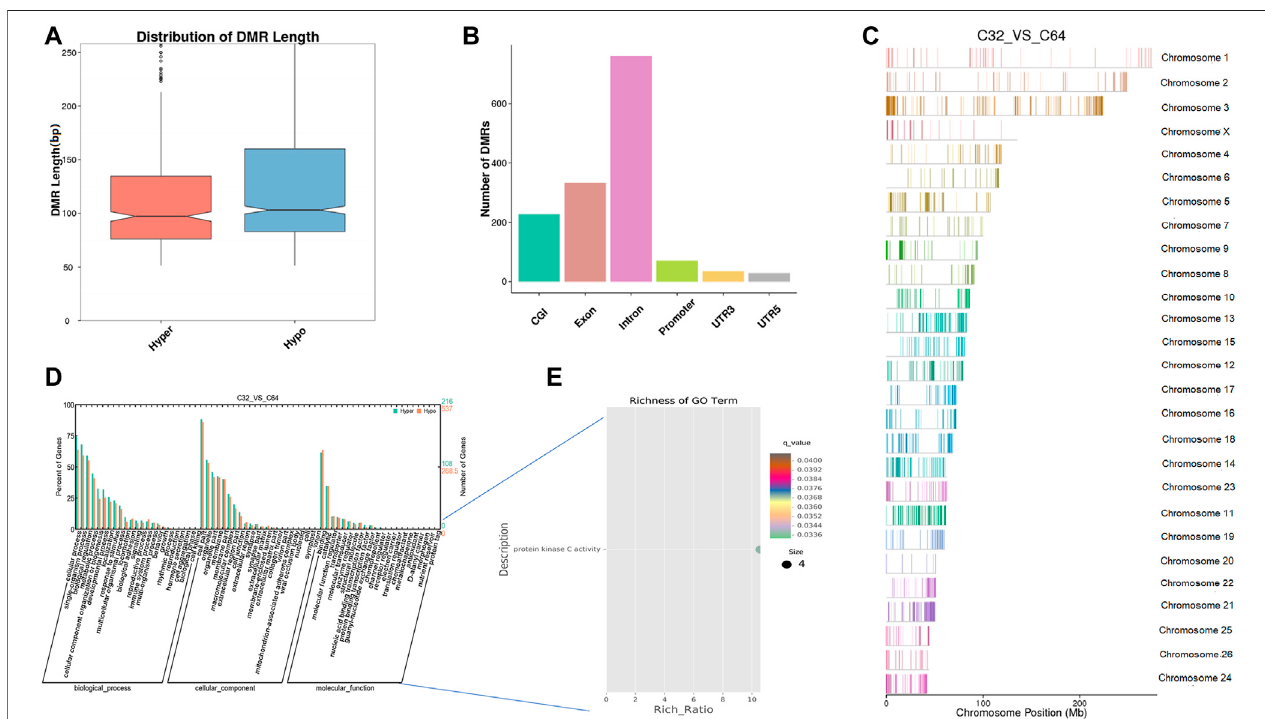
FIGURE 6 | Differentially methylated analysis from the morula stage to the blastocyst stage. (A – C) DMR length, functional annotation, and distribution in chromosomes at these stages. The length of DMRs: the horizontal axis represents the methylation status of the DMRs, Hyper is relatively hypermethylated, Hypo is relatively hypomethylated, and the vertical axis represents the DMR length (A) . The functional annotation of DMRs: the horizontal axis represents different genomic functional regions, promoters, exons, etc.; the vertical axis represents the number of DMRs annotated to a particular functional region (B) . The location of DMRs in thesheepgenome:thehorizontal axisrepresentsthechromosomal location,theverticalaxis represents thechromosome (C) . (D , E) GOenrichment analysis. Basedon the structural annotation results of the DMRs in the genome, functional enrichment analysis was performed for genes in which the DMR overlaps the promoter and the gene body. The abscissa is each major class under GO terms, the left ordinate is the proportion ofthe class, and the right ordinate is the speci fi cnumber ofgenes in the class. Differentcolorsrepresent differentgroups (D) .The signi fi cantlyenriched GOterm wasscreened forscatter plotdisplay. The sizeofeach dot indicates thenumber of differential methylated genes contained in the term, and the color of the dots corresponds to a different q -value. Rich Ratio refers to the ratio between the number of differentially methylated genes enriched in the GO term and the background number. The larger the Rich Ratio, the greater the degree of enrichment. The q -value is the adjusted p -value after multiple hypothesis testing. The q -value is (0,1). The smaller the q -value, the more signi fi cant the enrichment (E)